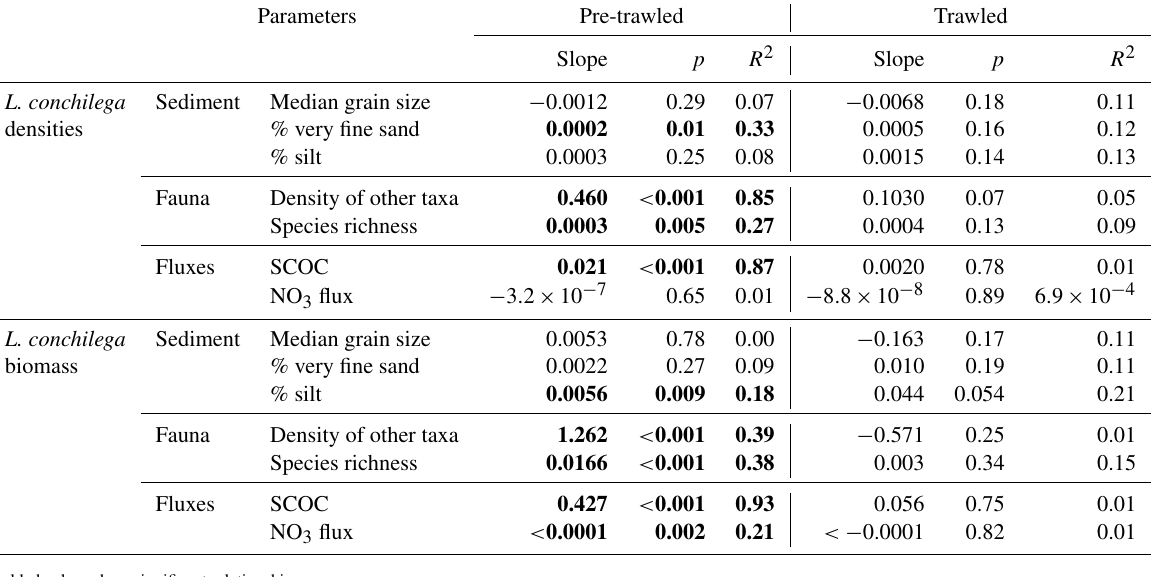
Table 2. Robust regression coefficients (slope, p value, multiple R squared) showing the relationship of Lanice conchilega densities and biomass versus sedimentary faunal and biogeochemical flux parameters in trawled and untrawled sediments. Parameters